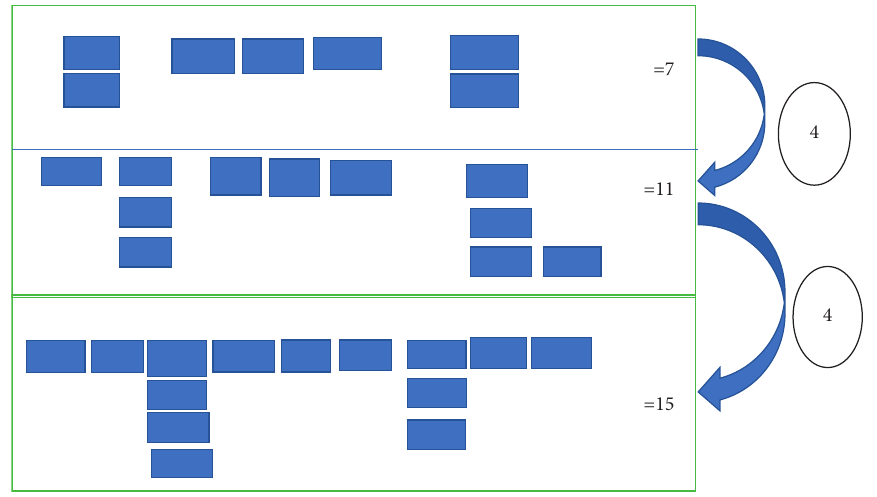
Figure 5: Work results of S1 subject in formulating